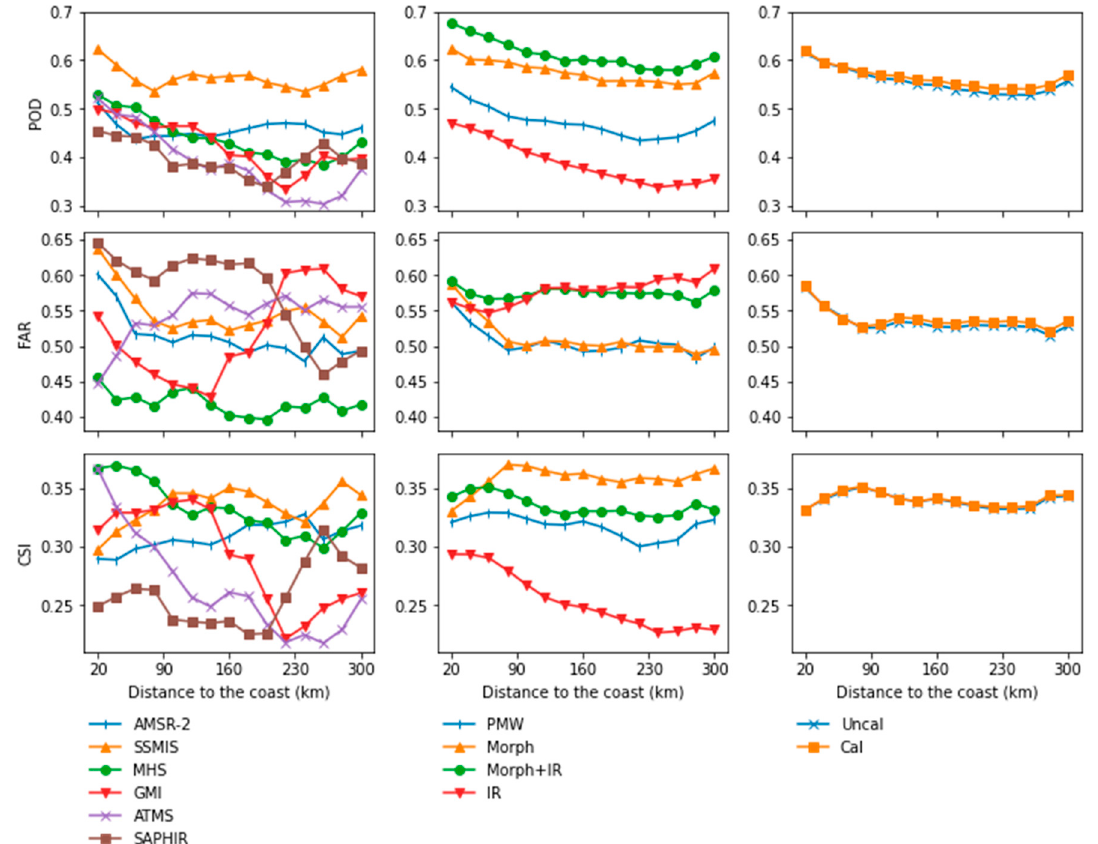
Figure 10. Three categorical indices, POD, FAR, and CSI, for 12 IMERG estimates according to the distance to the coast. The left, middle, and right columns indicate the IMERG estimates for the first, second, and third levels of evaluations.